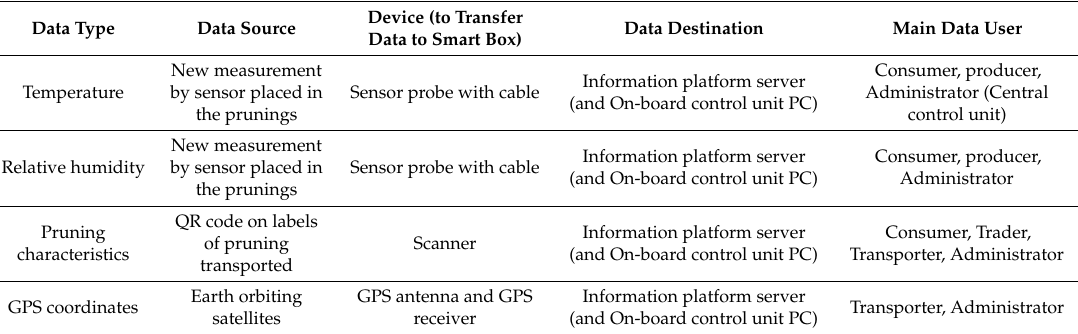
Table 3. Data type, source, destination and utilization.